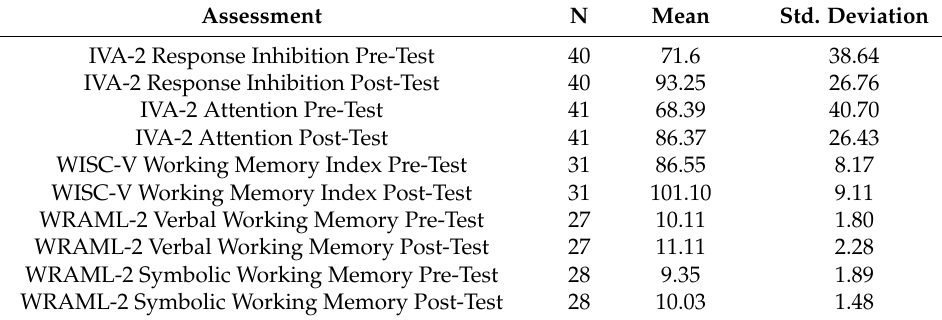
Table 1. Descriptive statistics for all cognitive measures.